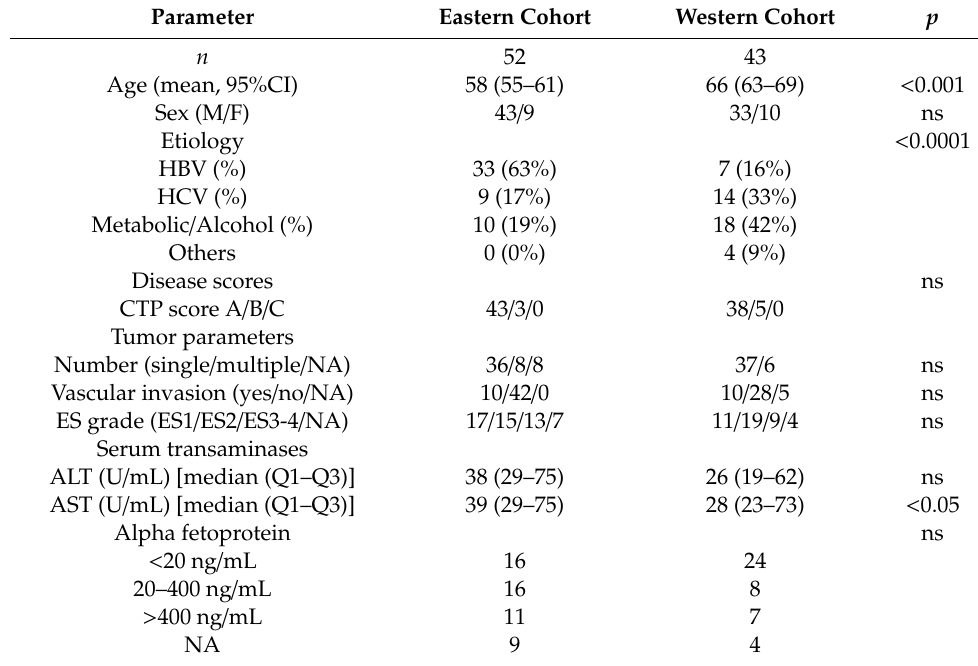
Table 1. Demography and clinical-pathological characteristics of the HCC patients in the study.